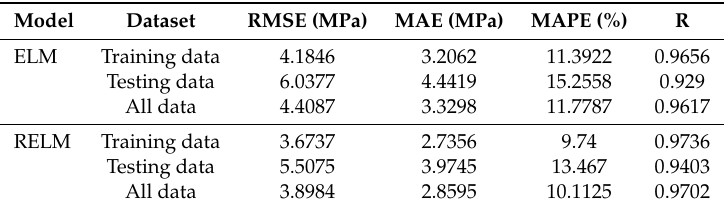
Table 3. Prediction results of the ELM and RELM models.